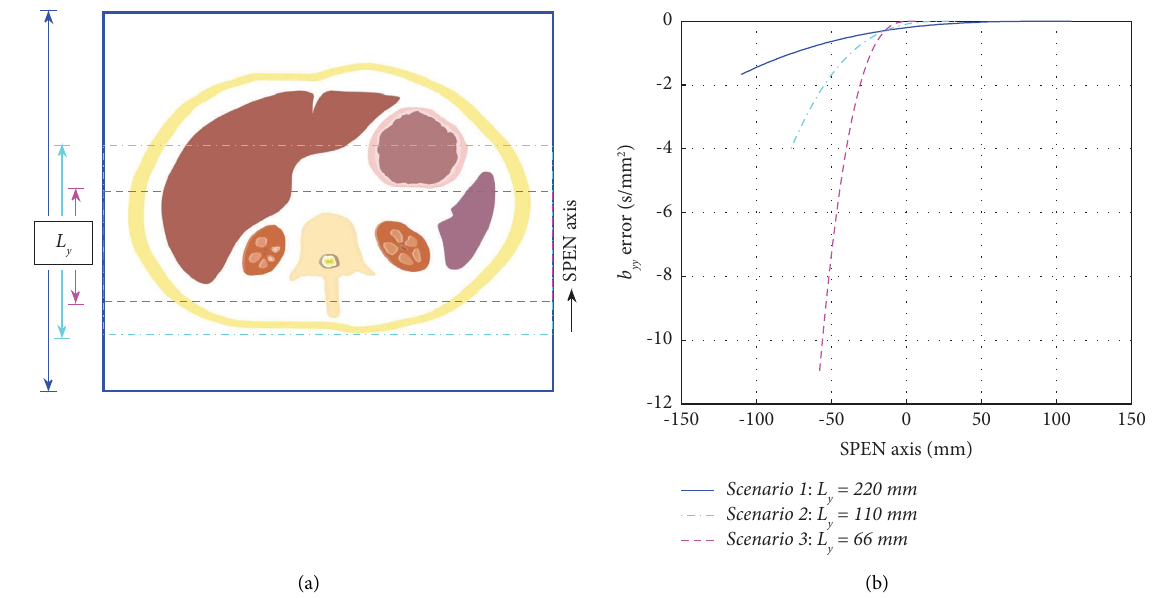
Figure 8: Te errors associated with approximate b yy calculation based on a uniform refocusing instant: (a) this illustrates three imaging FOVs selected from the human kidney sketch and (b) this plots the corresponding b yy errors along the SPEN axis within each imaging FOV.